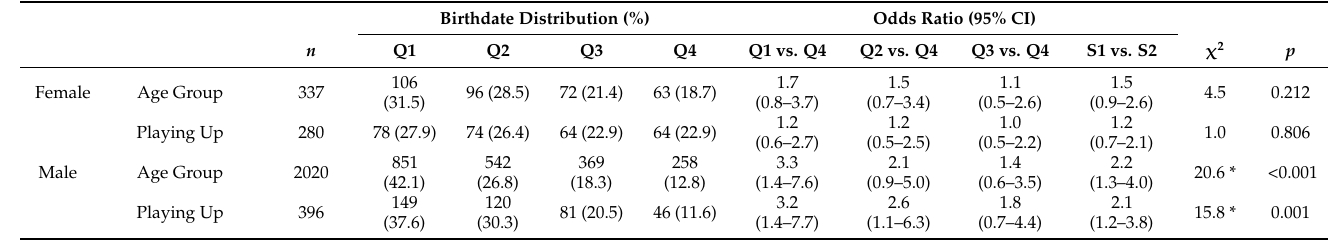
Table 3. Birth quartile distribution by sex and playing status (* Significant at an alpha level of p <